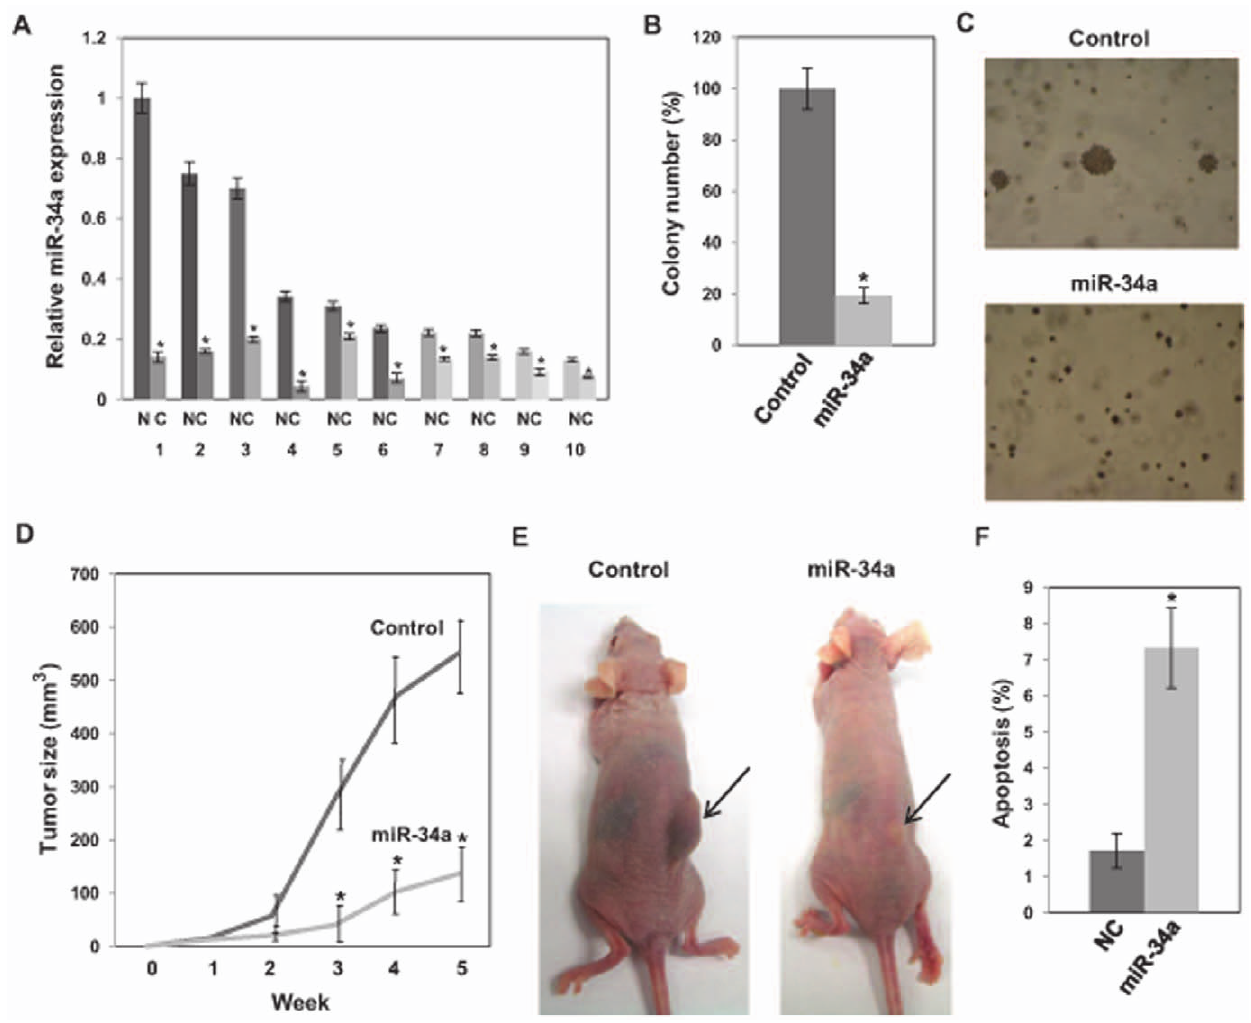
Figure 1. miR-34a inhibits cell growth. (A) Relative miR-34a expression in laser capture microdissected (LCM) prostate cancer tissues (C) and matched adjacent normal regions (N). (B) miR-34a overexpression suppresses soft agar colony formation of a stably transfected miR-34a PC-3 cell line. After 14 days incubation, colonies with over 50 cells were counted. The values are normalized to those of control. (C) Representative images of the colonies. (D) miR-34a inhibits in vivo tumor growth. Time course of tumor growth in nude mice after subcutaneous injection of a stably transfected miR-34a PC-3 cell line or control cell line. *, P , 0.05 compared with control. (E) Representative images of tumors in nude mice at 5 weeks after subcutaneous injection of a stably transfected miR-34a PC-3 cell line or control cell line. (F) miR-34a induces apoptosis in PC-3 cells. PC-3 cells were transfected with pre-miR negative control (NC) or pre-miR-34a for 3 days. PC-3 cells were stained with AnnexinV-FITC/7-AAD and apoptosis was analyzed by flow cytometry. The data shows the percentage of early apoptotic and apoptotic cells out of the total cell population of PC-3 cells. *, P , 0.05 compared with control.